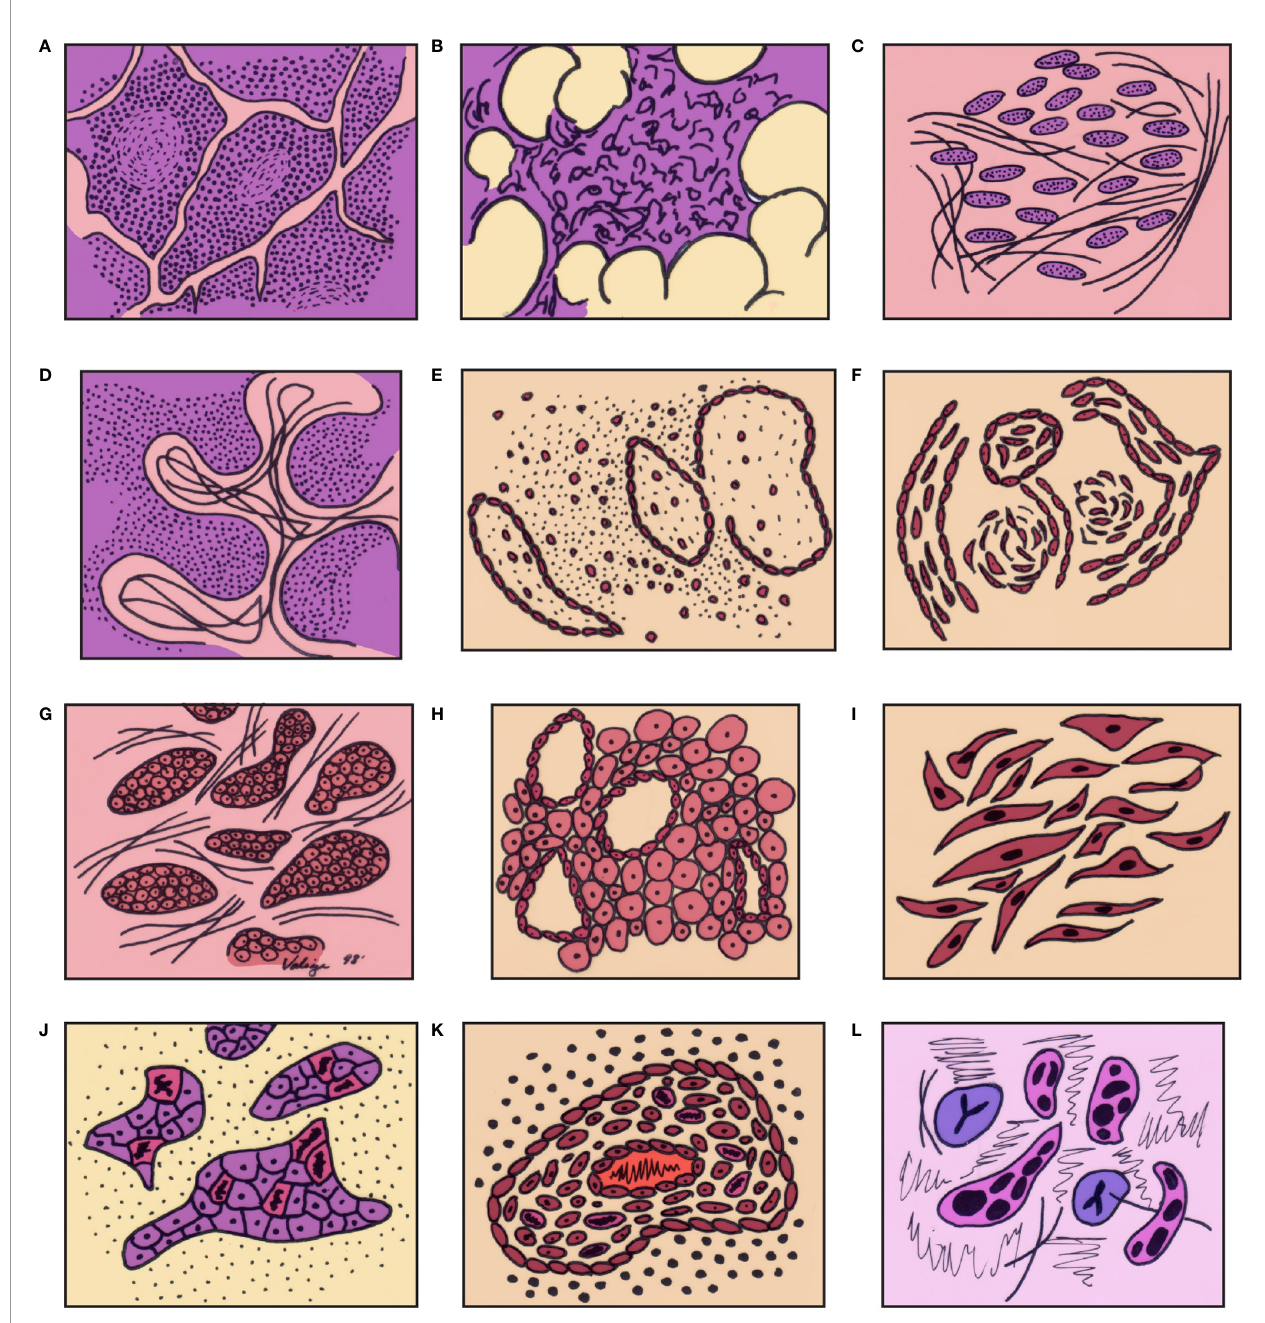
FIGURE 1 | Graphic illustration of the spectrum of differentiation of thymic epithelial neoplasms from normal thymus through high grade thymic carcinoma: (A) thymus in a child, (B) thymus in the adult, (C) thymus with involutional changes, (D) thymoma (lymphocyte rich – WHO type B1), (E) Thymoma (mixed cellularity – WHO type B2), (F) Spindle cell thymoma (WHO type A), (G) atypical thymoma – preservation of organotypical features, (H) atypical thymoma (perivascular spaces), (I) Atypical spindle cell thymoma, (J) thymic carcinoma – loss of organotypical features, (K) thymic carcinoma – in fl ammatory reaction, (L) thymic carcinoma – cellular atypia and mitotic activity in epithelial cells. (with permission from Dr. Moran copyright © Dr.